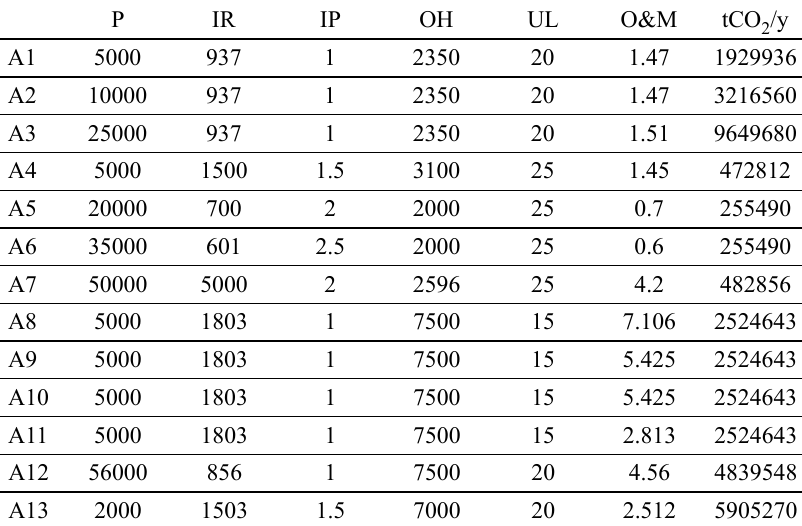
Table 3. Preference ratings of alternatives (Cristóbal